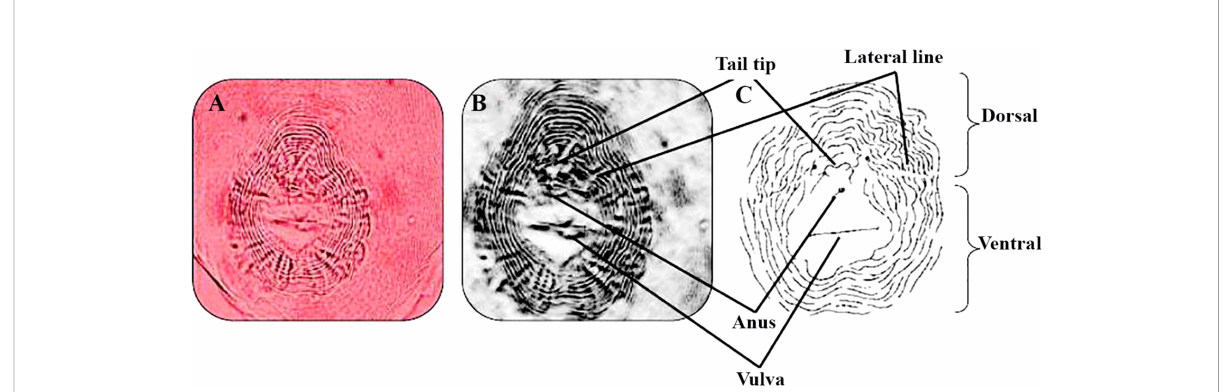
FIGURE 2 Perineal pattern of Meloidogyne incognita . Dissected female sections showed a characteristic oval shape of the rounded perineal pattern, typically with a high dorsal arch and usually wavy striae, which bend towards the lateral lines and may be absent from the distinct lateral fi eld or weakly demarcated by forked striae typical of this species M. incognita . (A – C) M. incognita (Kofoid and White, 1919; Chitwood, 1949) perineal patterns (scale for light microscopy photos =10 m